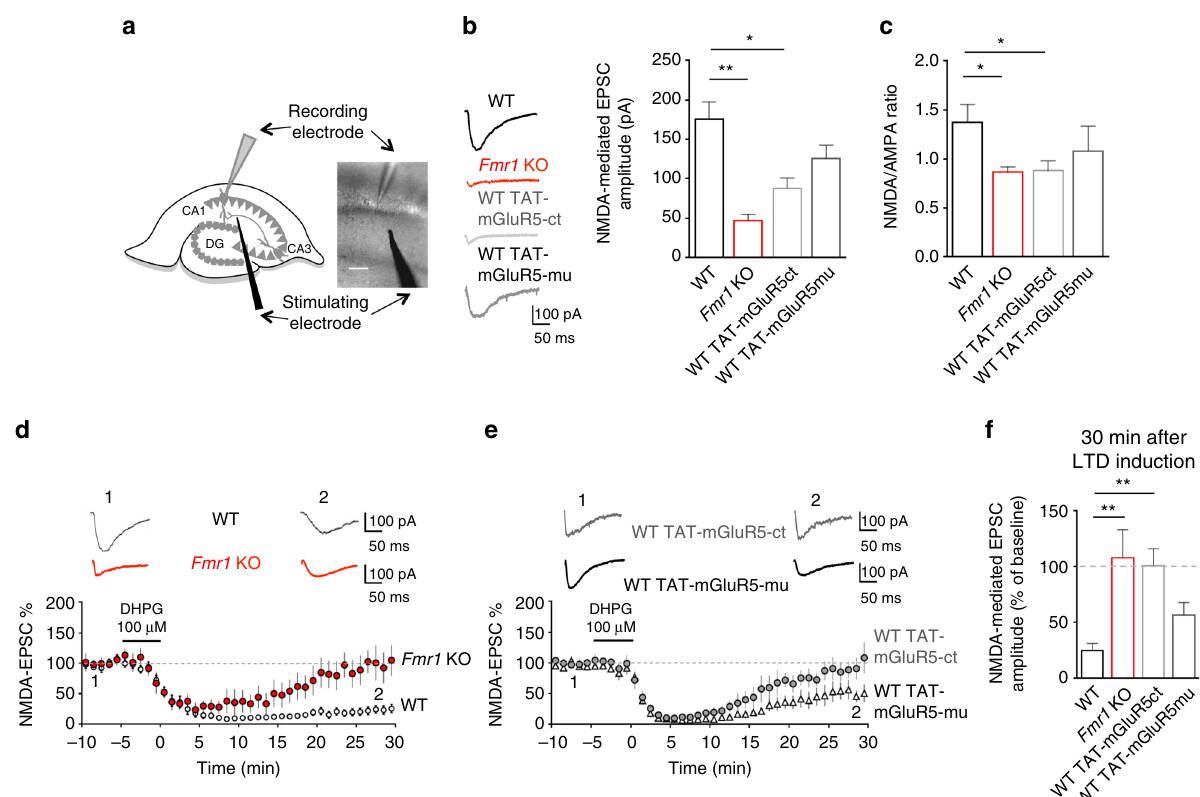
Fig. 5 Disruption of mGluR5/Homer coupling alters synaptic NMDAR function and plasticity. ( a ) NMDAR-mediated excitatory post-synaptic currents (EPSCs NMDA ) were recorded from CA1 pyramidal neurons. Scale bar = 100 μ m ( b ) Left: representative EPSCs NMDA traces from WT, Fmr1 KO, WT treated with either TAT-mGluR5ct or TAT-mGluR5mu (both 5 µ M, 4 h). Histograms: EPSCs NMDA amplitude (F (3, 35) = 6.26; ** P = 0.0016; one-way ANOVA with Tukey ’ s Multiple Comparison). Compared to WT (175.7 ± 21.9 pA, n = 11 neurons from 7 animals), EPSCs NMDA were lower in Fmr1 KO (46.4 ± 8.4 pA, n = 7 neurons from 4 animals, ** P < 0.01) and in WT treated with TAT-mGluR5ct (88.1 ± 12.7 pA, n = 13 neurons from 7 animals, * P < 0.05) but not with TAT-mGluR5mu (125.9 ± 16.8 pA n = 8 neurons from 3 animals, P = 0.14). ( c ) NMDA/AMPA ratio in WT, Fmr1 KO, WT treated with TAT-mGluR5ct or TAT-mGluR5mu (F (3, 32) = 4.1; * P = 0.013; one-way ANOVA with Tukey ’ s Multiple Comparison). NMDA/AMPA ratio (in WT 1.37 ± 0.17, n = 9 neurons from 4 animals) was reduced in Fmr1 KO (0.86 ± 0.05, n = 8 neurons from 3 animals, * P = 0.02) and in WT treated with TAT-mGluR5ct (0.88 ± 0.10, n = 9 neurons from 3 animals, * P = 0.02). ( d , f ) The mGluR1/5 agonist DHPG (100 µ M, 5 min) induced long-term depression (mGluR-LTD) of EPSCs NMDA in WT (EPSCs NMDA amplitude: 24.9 ± 2 % of baseline, n = 8 neurons from 5 animals) but not in Fmr1 KO (EPSCs NMDA 107.8 ± 25 %, n = 6 neurons from 4 animals, ** P < 0.01, WT vs. Fmr1 KO). ( e , f ) mGluR-LTD of EPSCs NMDA was abolished in WT treated with TAT-mGluR5ct (EPSCs NMDA 100.6 ± 15 %, n = 8 neurons from 7 animals, ** P < 0.01, WT vs. TAT-mGluR5ct) but not with TAT-mGluR5mu (EPSCs NMDA 56.6 ± 11 %, n = 7 neurons from 3 animals). ( f ) mGluR-LTD magnitude in all conditions (F (3, 19) = 7.27, ** P = 0.0019, one-way ANOVA with Tukey ’ s Multiple